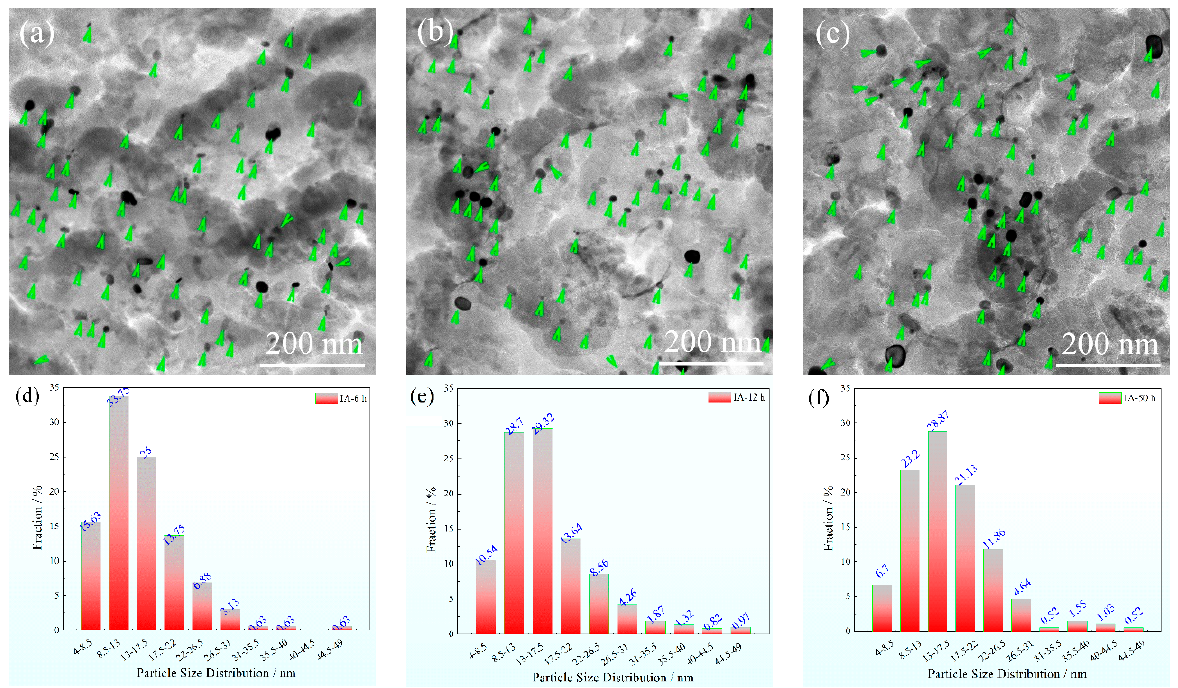
Figure 9. Precipitation particles’ characterization: ( a – c ) TEM images of precipitation particles for IA-6 h, IA-12 h and IA-50 h, respectively; ( d – f ) particle size distribution lower than 50 nm for IA-6 h, IA-12 h and IA-50 h, respectively.